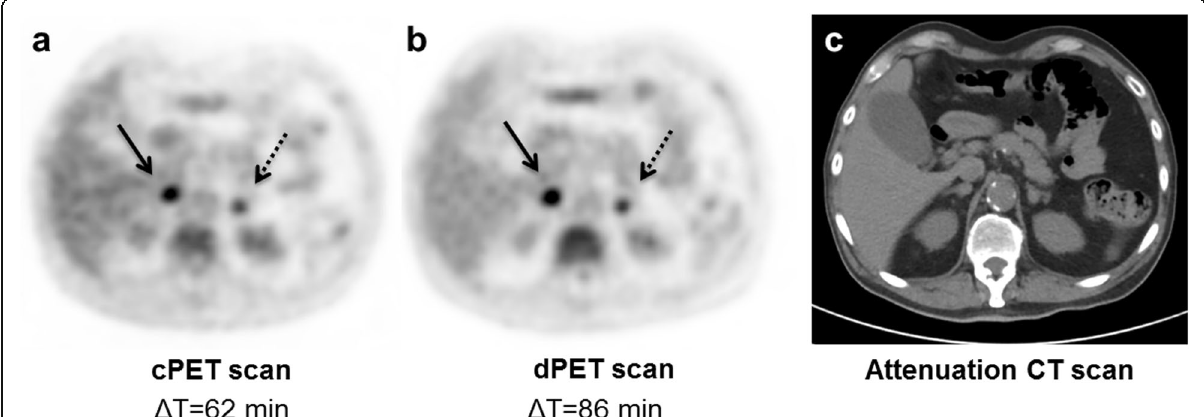
Fig. 5 Axial FDG-PET/CT images ( a , b and c ) from a lung cancer patient with bilateral adrenal gland metastases showing higher SUVs on the dPET scan ( b ) that was acquired 24 min after the cPET scan ( a ). The left-gland metastasis (diameter 11 mm) showed Δ SUVs of 7% (SUV mean ), 10% (SUV peak ) and 15% (SUV max ). Δ SUVs of the right-gland metastasis (diameter 14 mm) were 13% (SUV mean ) and 11% (SUV peak and SUV max ). In this case the impact of the digital scanner cannot be separated from the SUV rise caused by the prolonged FDG-uptake. Meanwhile, the visual image quality of both PET scans appeared comparable in terms of image noise, texture and FDG-uptake as intended with an EARL-compatible